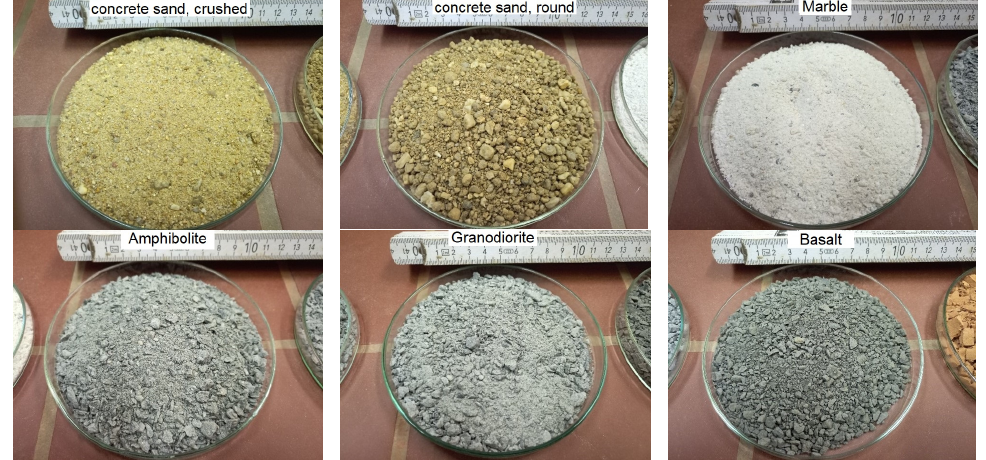
Figure 1. Potential primary sand sources crushed and round river concrete quartz sand and m-sand substitutes in form of rushed solid rocks: marble, amphibolite, granodiorite (a form of granite), and basalt (Figure source: Radek Kucera).